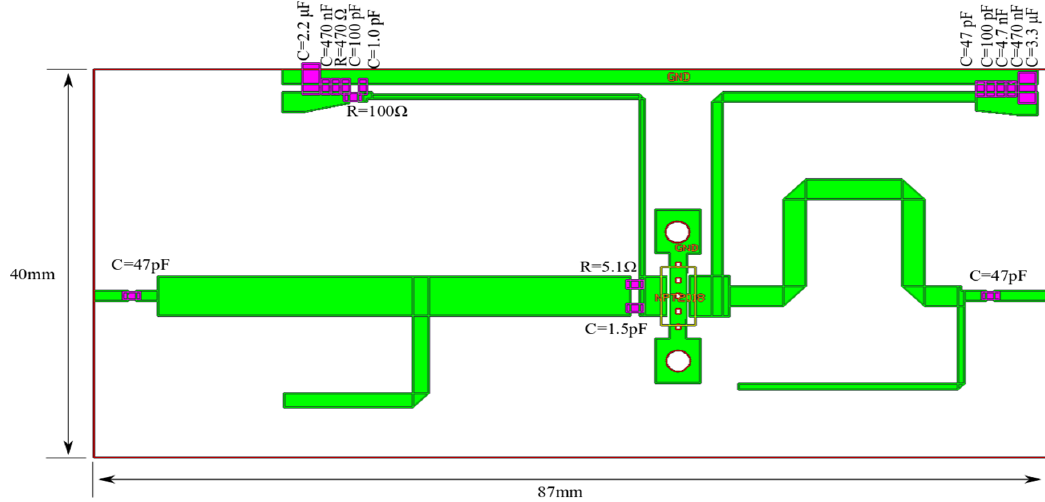
Figure 7. Assembly drawing of the test PA with GaN HEMT NTP2018.